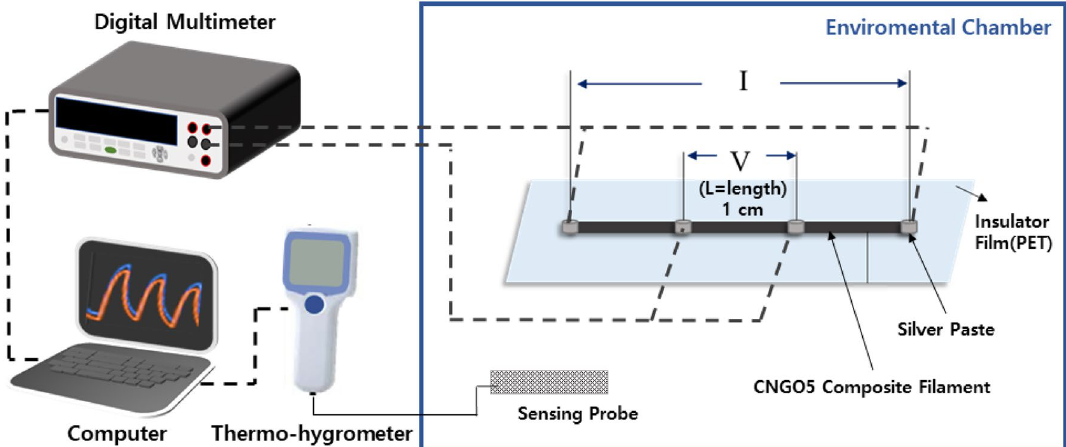
Figure 2. Schematic diagram of the electrical resistance measurement using the four-point probes